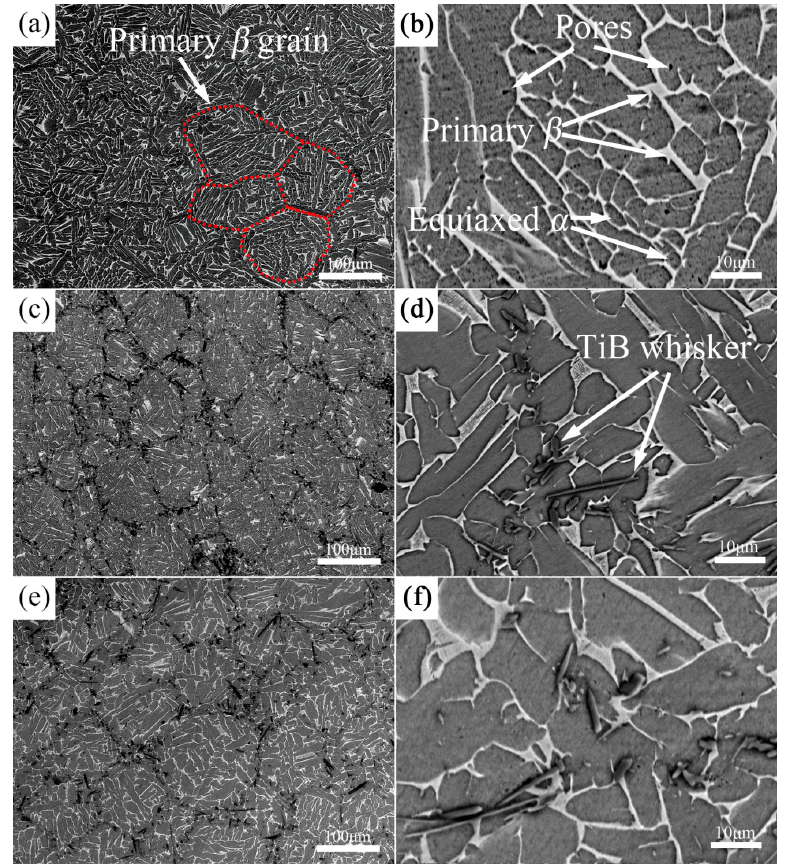
Figure 4. SEM micrographs of 0 vol % ( a , b ); 2.5 vol % ( c , d ); and 5 vol % TiBw/TA15 ( e , f ) with low magnification ( a , c , e ) and high magnification ( b , d , f ).